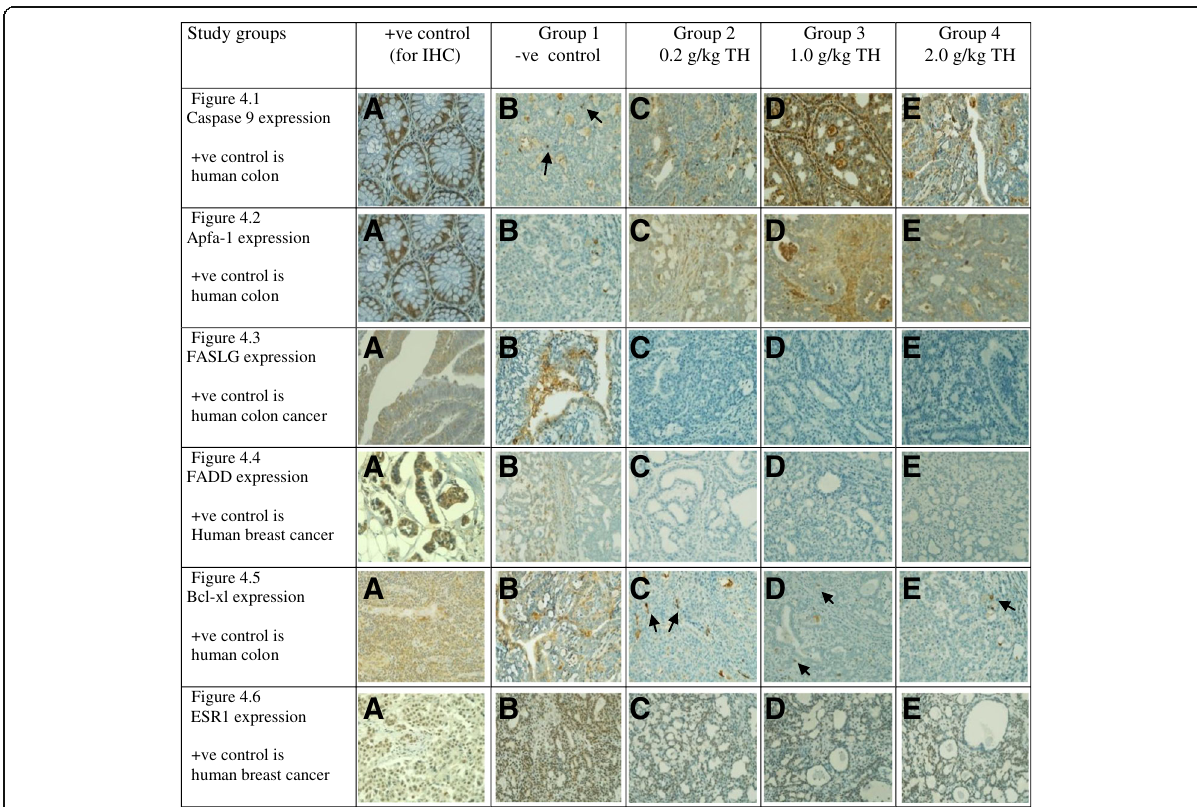
Fig. 5 The immunohistochemical (IHC) expression of pro-apoptotic proteins; Caspase 9, Apaf-1, FASLG, FADD and anti-apoptotic proteins; Bcl-xl, ESR1 in TH treated tumors compared to the tumors of untreated control. A = +ve control for immunohistochemistry (IHC) analysis, B = − ve control for study (untreated tumor bearing rats), C = 0.2 g/kg TH, D = 1.0 g/kg TH and E = 2.0 g/kg TH. All specimens were examined at X400 microscopic magnification and brown color show antibody positivity. FASLG and FADD showed no expression in tumors of all treatment groups, while tumors in treated groups showed higher expression of pro-apoptotic proteins than those of non-treated control. Legend: TH = Tualang